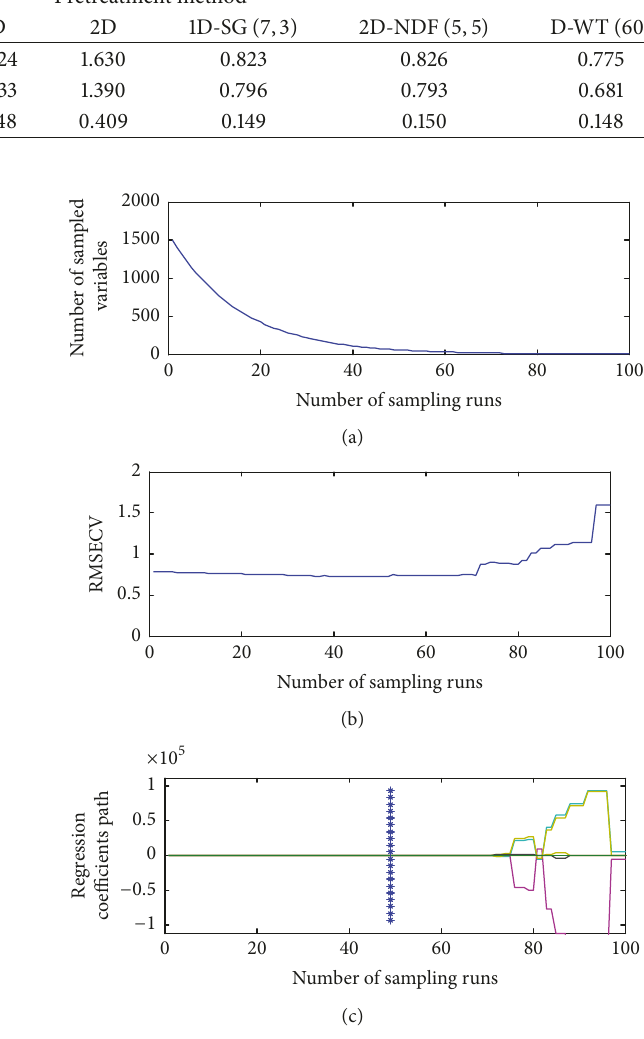
Figure 4: Changing trends in (a) number of sampled variables, (b) 5-fold RMSECV values, and (c) RC of each variable as the number of sampling runs increases. In (c), the line (marked by asterisks) indicates the optimal point where the 5-fold RMSECV values are